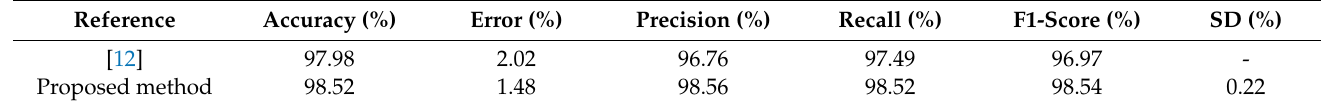
Table 6. Performance comparison in the recognition of 40 double-hand dynamic ASL words.